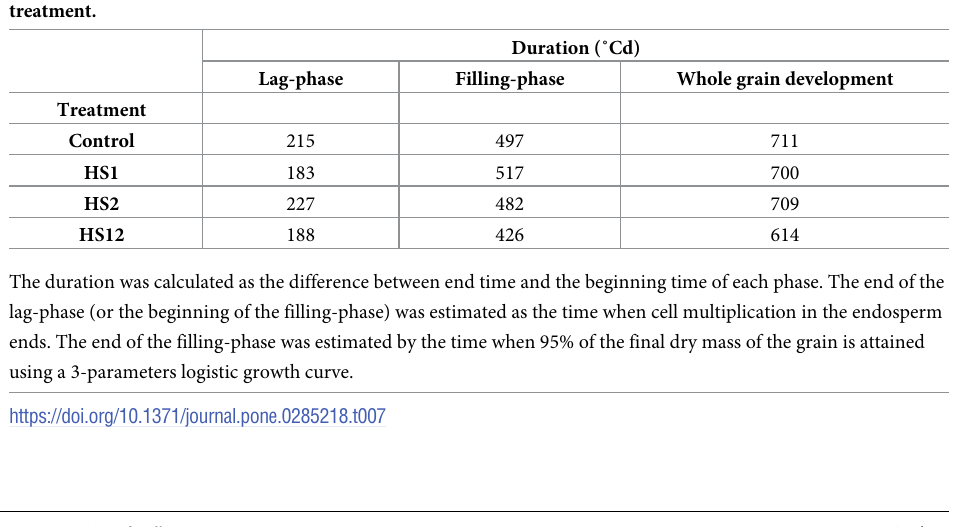
Table 7. Duration, expressed in ˚Cd, of the different phases of the grain development for each heat shock treatment.